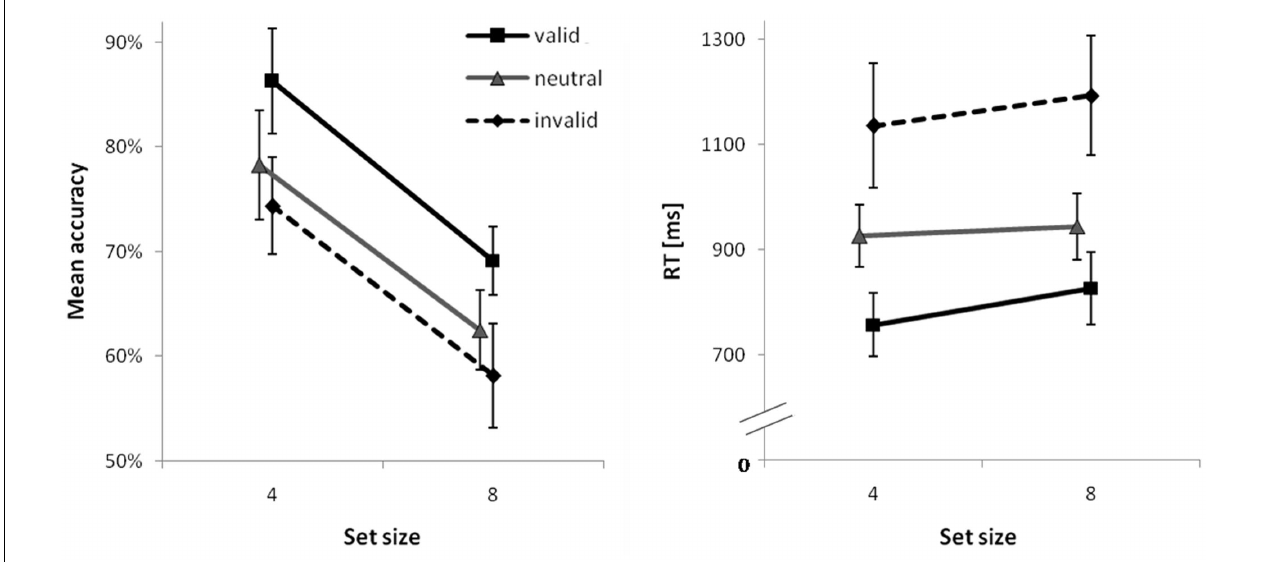
FIGURE 3 | Mean percent correct (PC; Left) and mean correct response times (RTs; Right) for the second delay of 400 ms as a function of set size and cue type. Error bars are 95% confidence intervals for each data point.